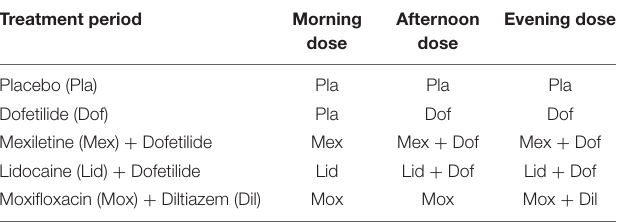
TABLE 1 | Dosing schema for study B, modified from Johannesen et al. (2016). Treatment period Morning